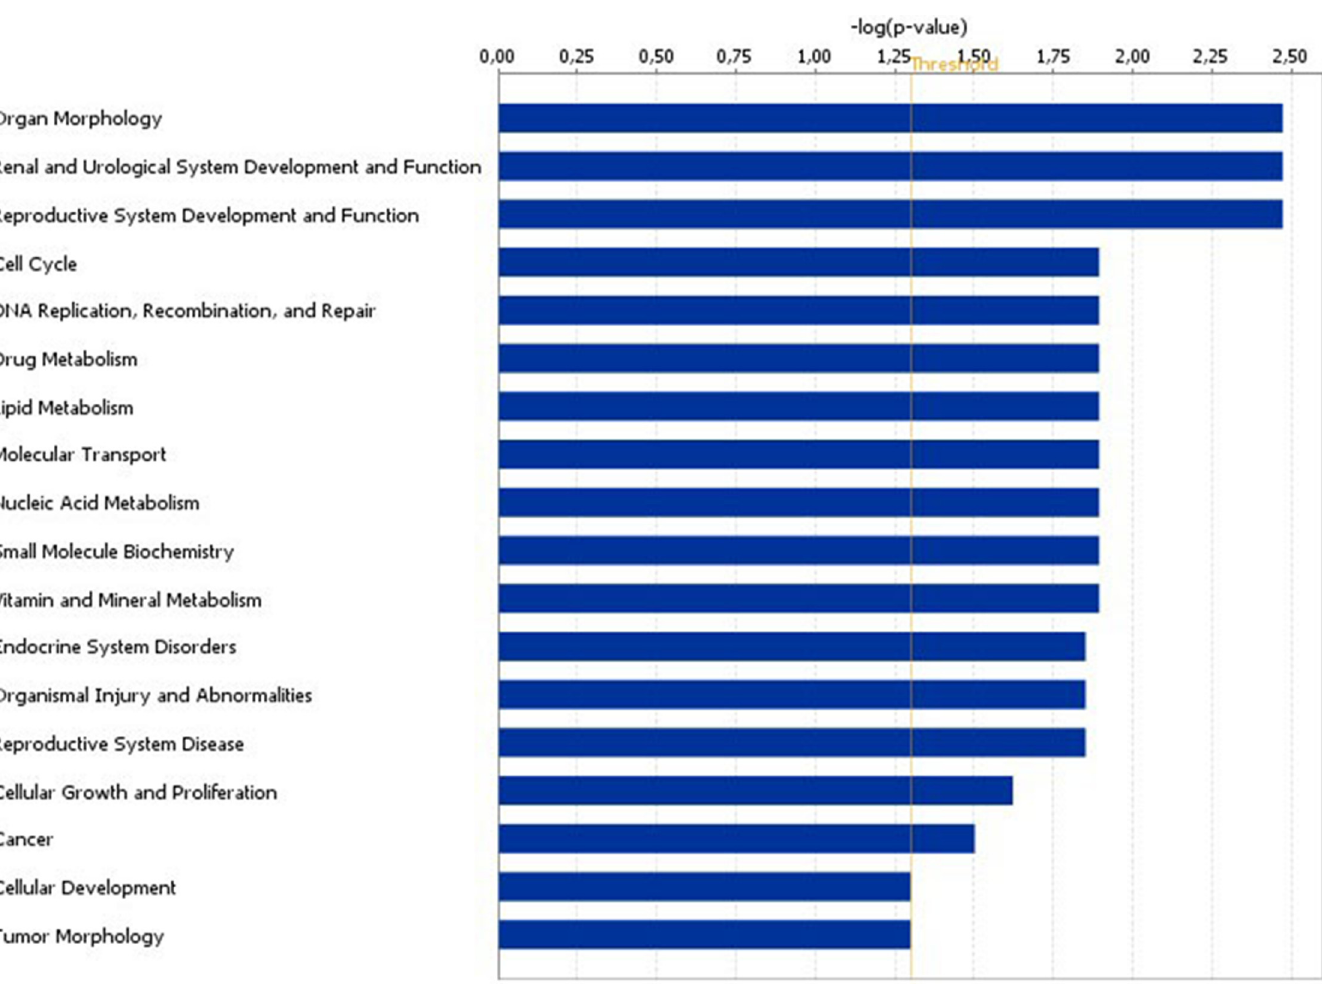
Fig 3. Affected “ Diseases and Functions ” in granulosa cells under acute pre-ovulatory heat stress conditions. Only significantly affected functions with p < 0.05 (indicated threshold line) according to bioinformatics IPA analysis were shown.